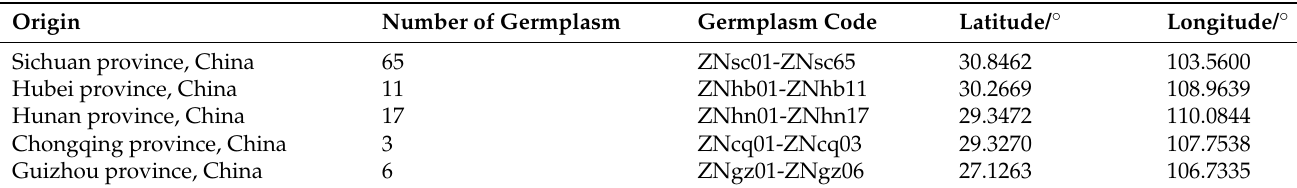
Table 1. The origins of germplasms used in this